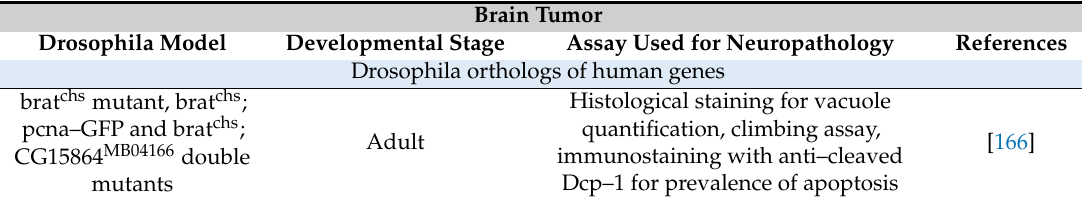
Table 7. Drosophila model of a neurodegenerative brain